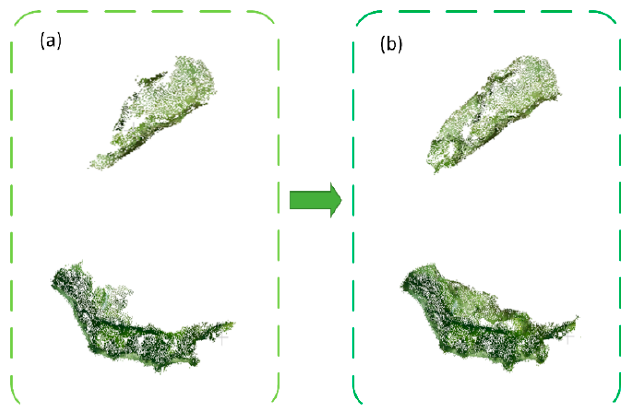
overlapped with each other at stage T2 and cannot be segmented properly into individual leaves.